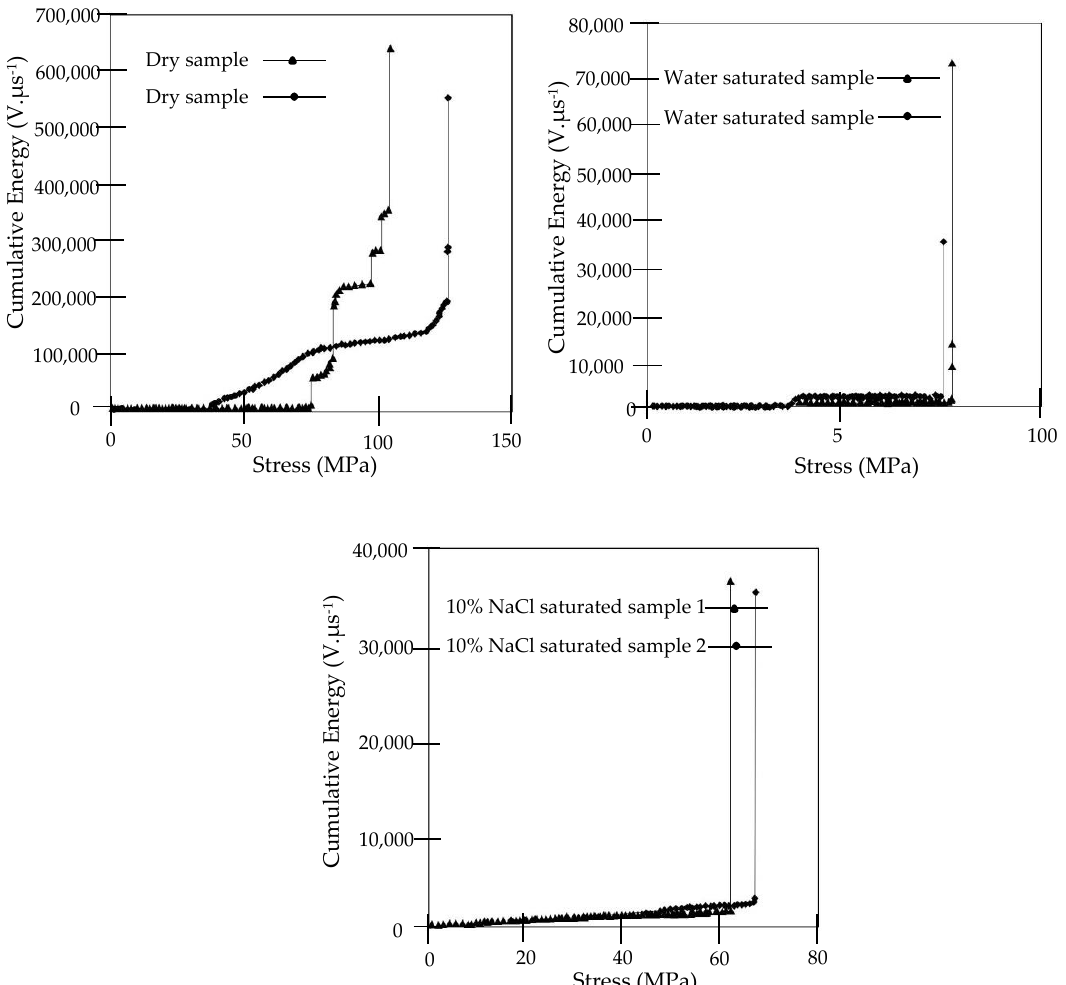
Figure 6. Cumulative energy vs. stress curves for varyingly saturated siltstones, which indicates the crack propagation ranges of samples upon mechanical loading.